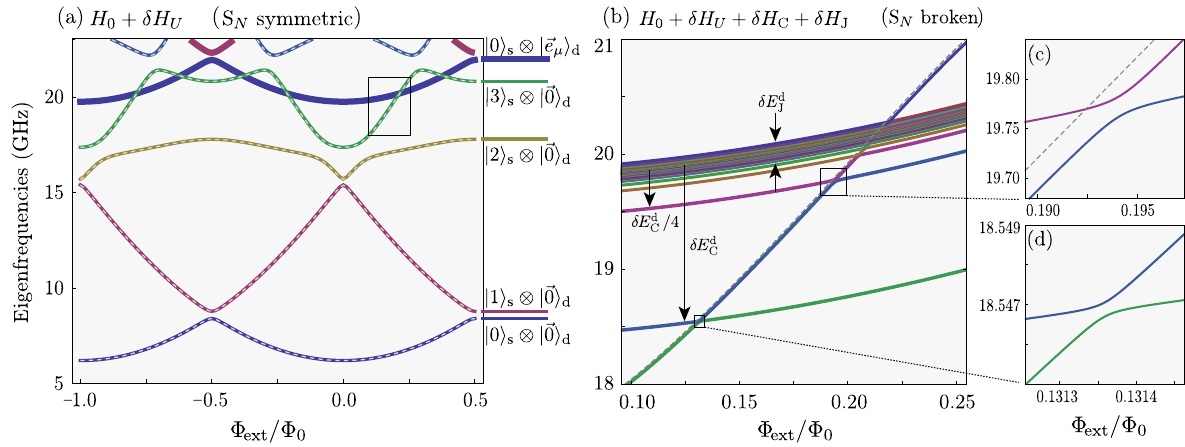
FIG. 5. Spectrum from numerical diagonalization, including the effects of (a) anharmonicity and of (b) anharmonicity, ground and E L [Eq. (10)]. capacitances, and junction disorder. The dashed curves show the pure superinductance spectra for renormalized E si C The thick curves in (a) indicate N (cid:3) 1 -fold degenerate levels that remain decoupled from T ¼ 0 states under (cid:8)H U . (b) Corrections and junction disorder (cid:8)H break S N symmetry. In the T ¼ 1 manifold, ground capacitances split off from ground capacitance (cid:8)H C J , here chosen from a Gaussian distribution. (c) and (d) show several levels; smaller shifts are due to junction disorder (cid:8)E d J (cid:6) magnifications of regions marked in (b). The avoided crossing in (c) is primarily generated by ground capacitances. The even smaller splitting in (d) is purely generated by array-junction disorder. The chosen parameters are consistent with the experimental device (Appendix